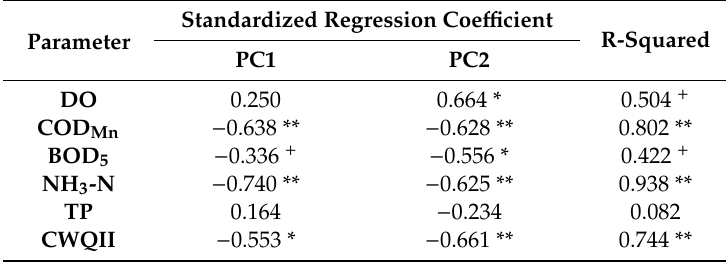
Table 4. Regression estimations of the water quality